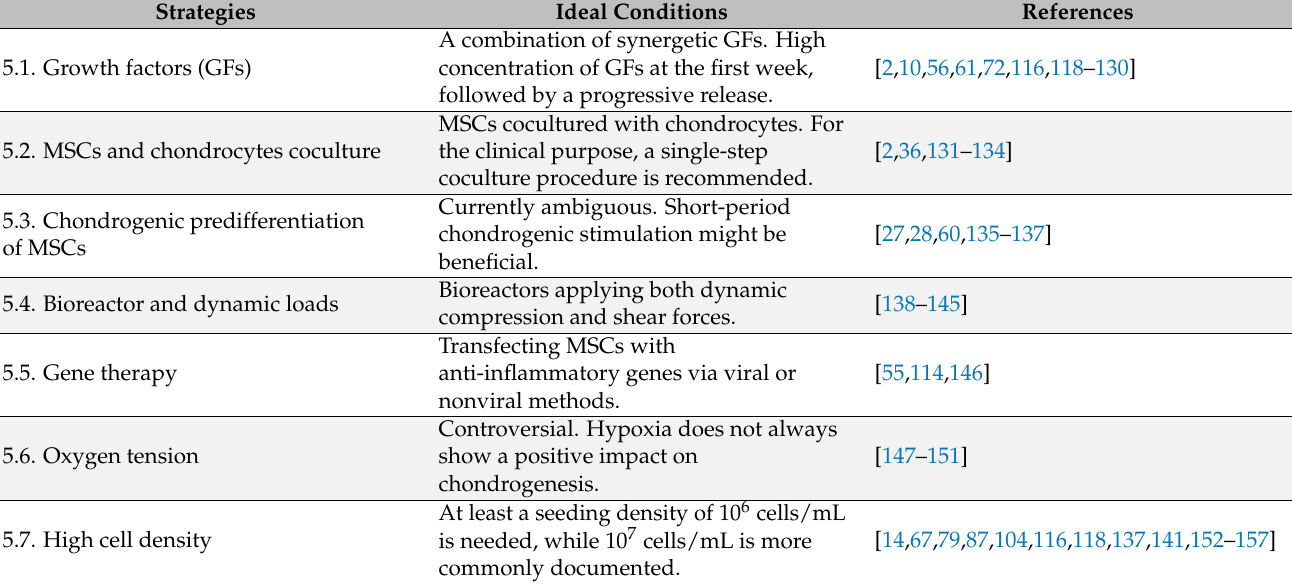
Table 3. Summary of strategies used to enhance chondrogenic MSC differentiation. Strategies Ideal